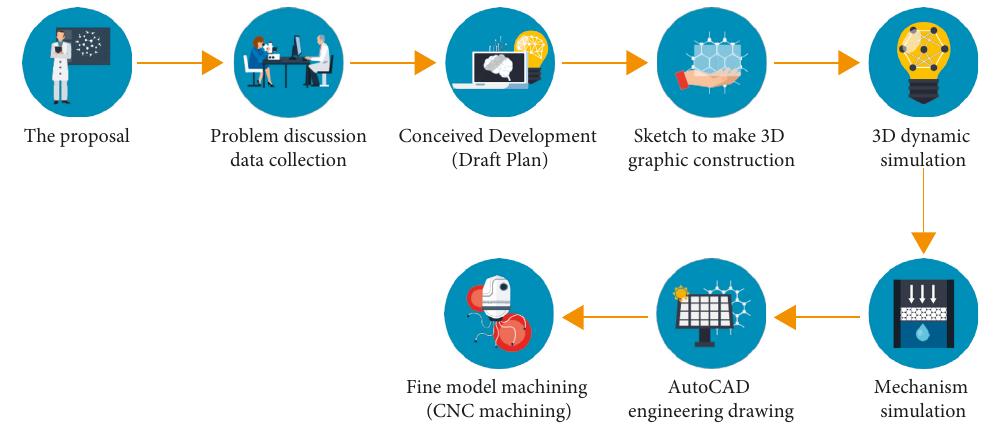
Figure 1: Mechanical manufacturing